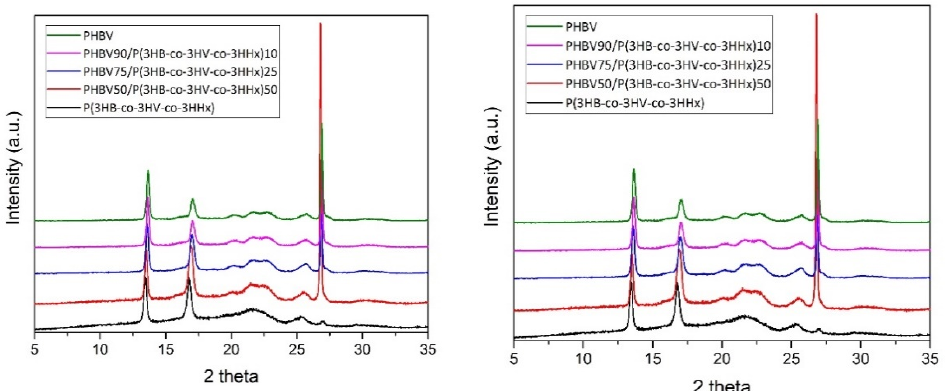
Figure 4. Wide angle X-ray diffraction (WAXD) patterns in the 2theta (2 θ ) ranges 5–35 ◦ ( left ) and 12–18.5 ◦ ( right ), from top to bottom, of the thermo-compressed films of: Neat poly(3-hydroxybutyrate- co -3-hydroxyvalerate) (PHBV); PHBV90/P(3HB- co -3HV- co -3HHx)10; PHBV75/P(3HB- co -3HV- co -3HHx)25; PHBV50/P(3HB- co -3HV- co -3HHx)50; and neat poly(3-hydroxybutyrate- co -3-hydroxyvalerate- co -3-hydroxyhexanoate) [P(3HB- co -3HV- co -3HHx)]. The data was normalized to the intensity of the (020) peak and shifted along the Y -axis for comparison